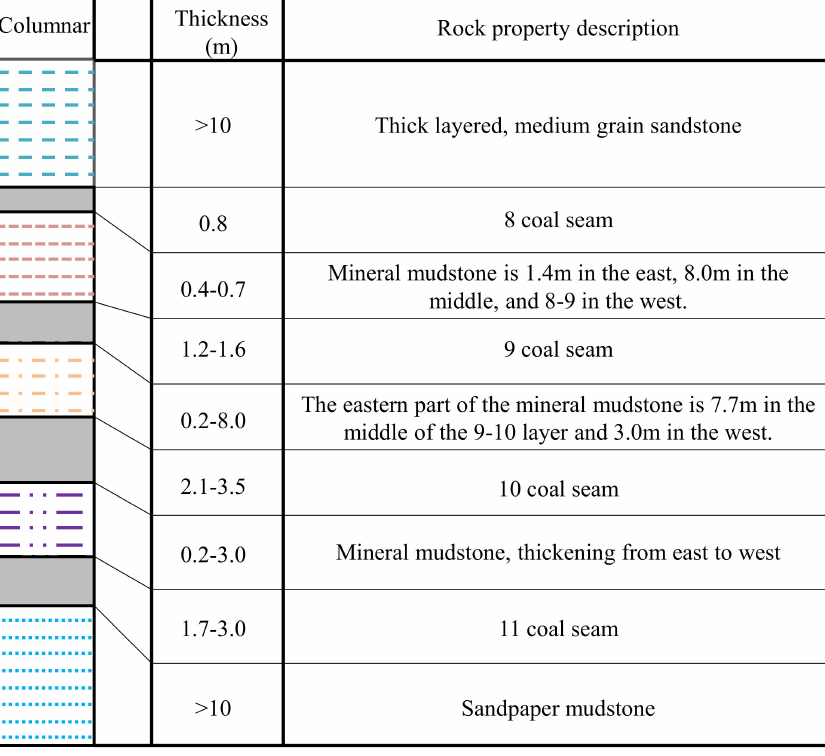
Figure 8. Seam histogram of group